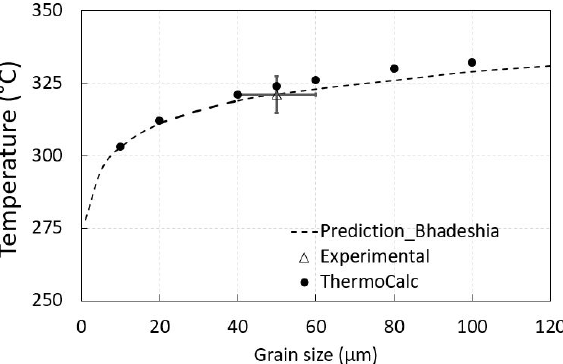
Figure 2. Variation of martensite start (Ms) in dependence to grain size. The prediction was done by using Equation (2).